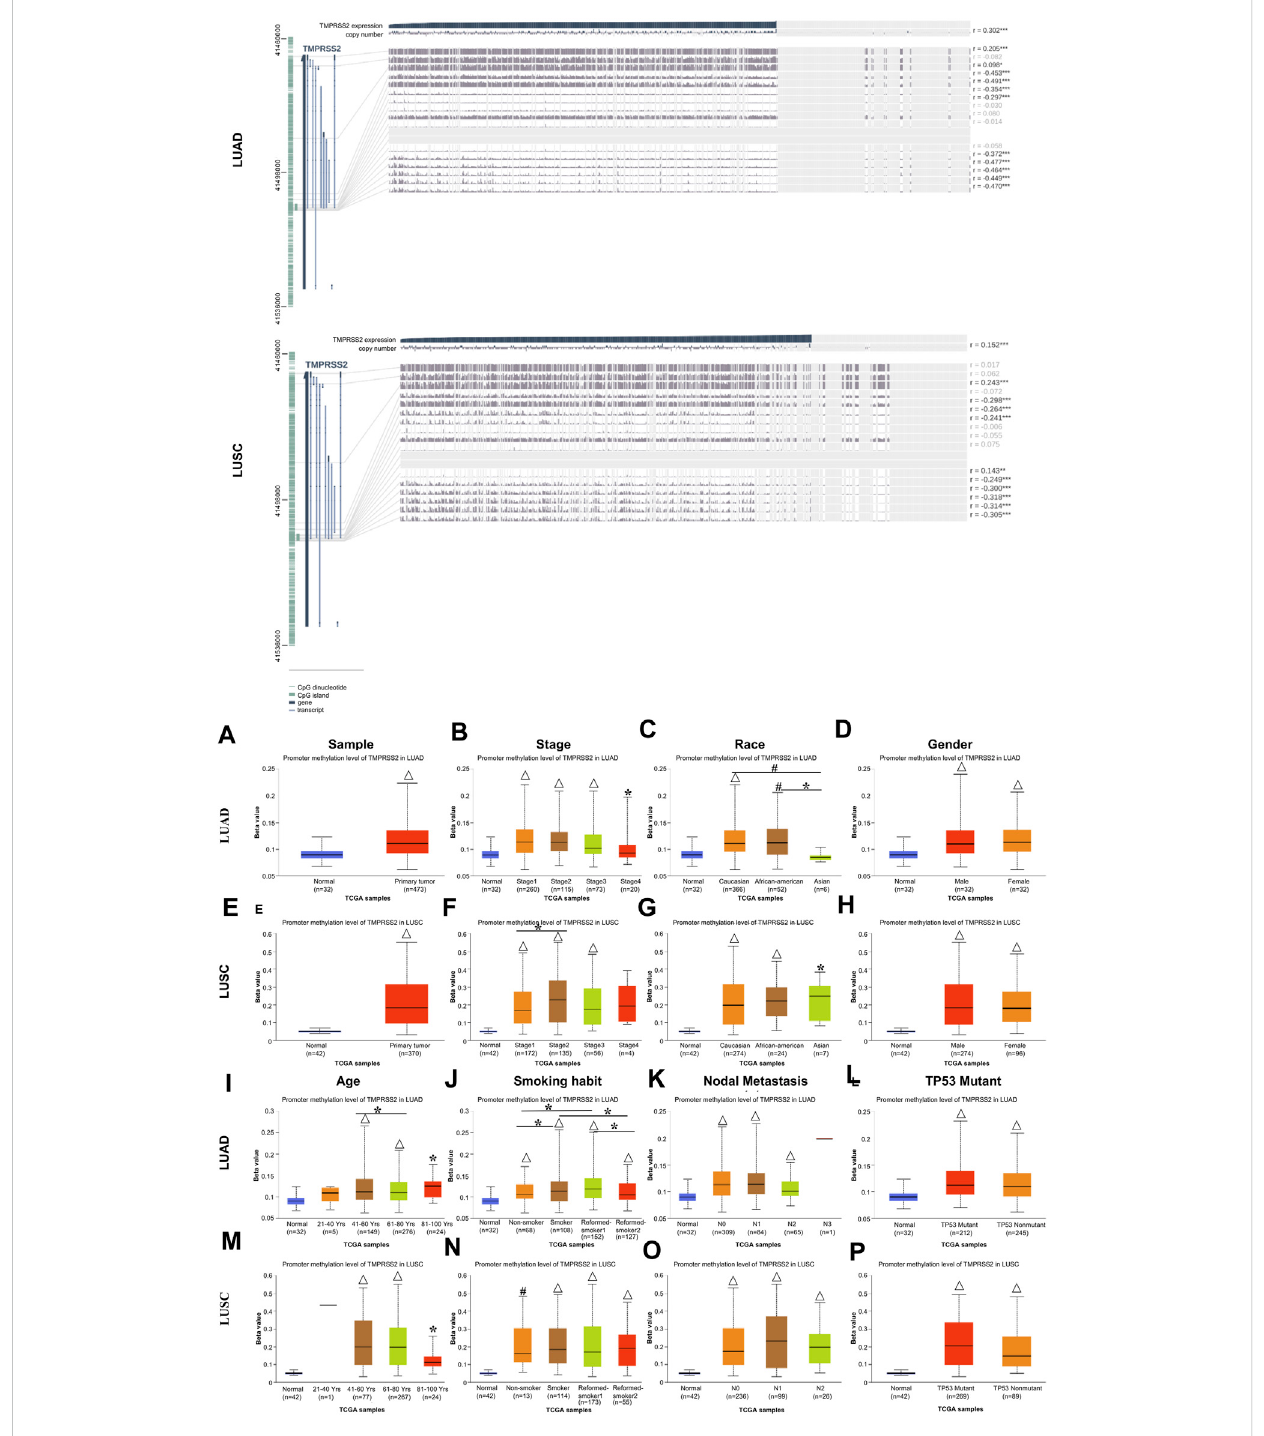
FIGURE 3 VisualizationofpromotermethylationlevelsofTMPRSS2impacttheclinicopathologicalparametersinLUADandLUSCusingMEXPRESS(upper)and UALCAN(lower).ThepromotermethylationlevelofTMPRSS2ofsampletypes (A,E) ,stage (B,F) ,race (C,G) ,gender (D,H) ,age (I,M) ,smokinghabit (J,N) , nodal metastasis status (K, O) and TP53 mutant (L, P) in LUAD and LUSC cohorts respectively. * p ≤ 0.05, # p ≤ 0.001, △ p ≤